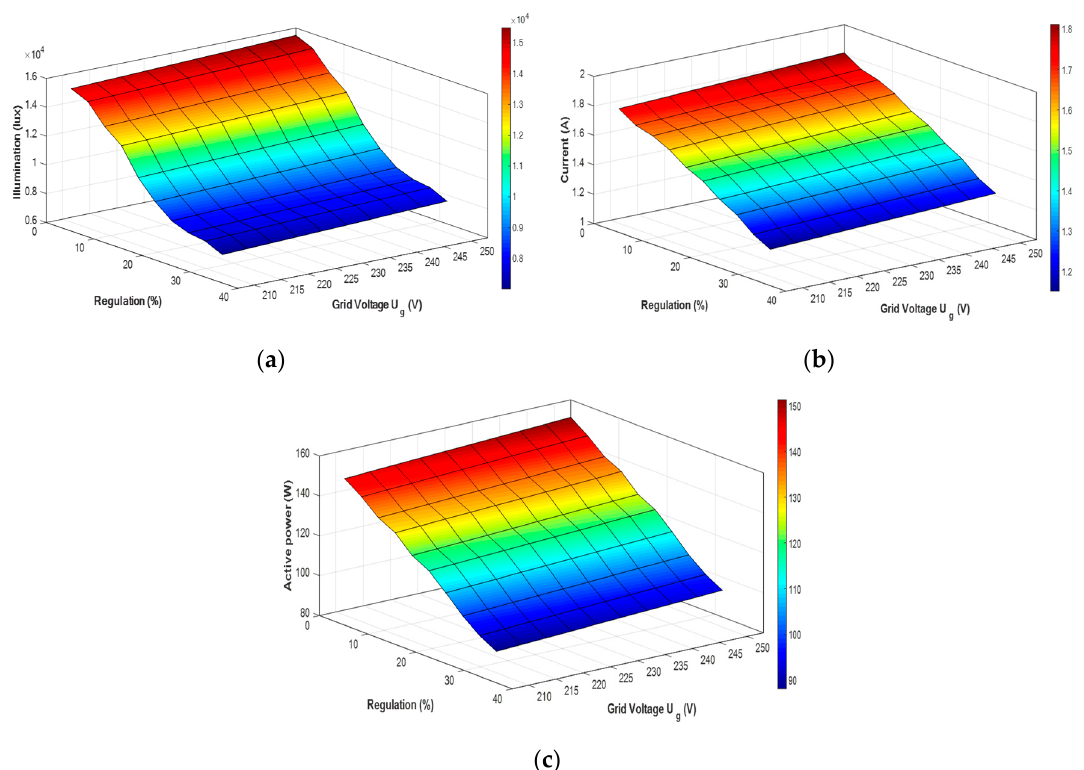
Figure 13. CDO Lamp regulation: ( a ) Illumination; ( b ) Current; ( c ) Active power.